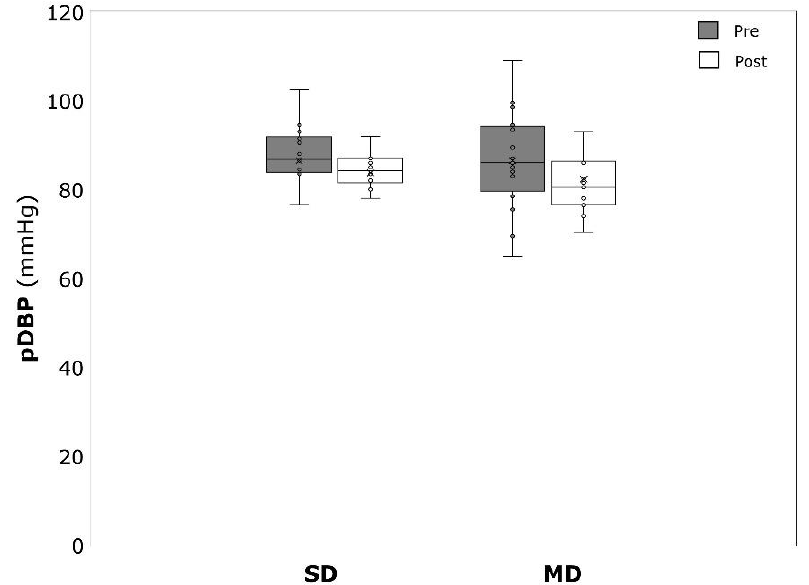
Figure 3. Peripheral diastolic blood pressure (pDBP) before (pre) and after (post) the intervention period for severely depressed (SD) and mildly depressed (MD).